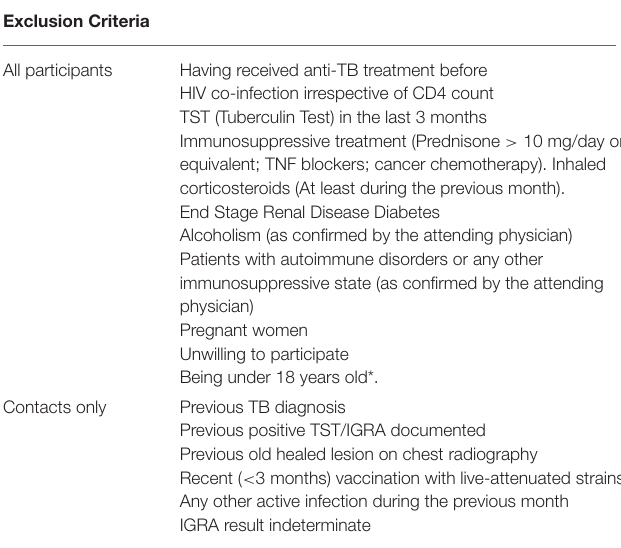
TABLE 1 | Exclusion criteria for participants’